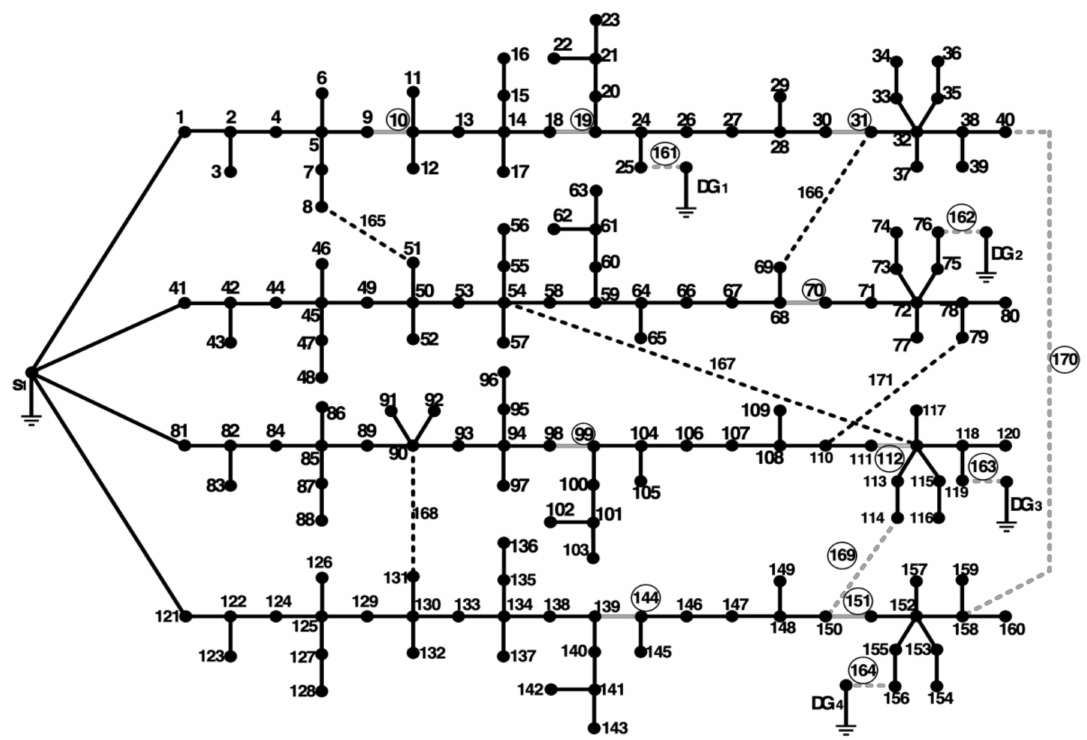
Figure 5. 4-feeder 1069-node test